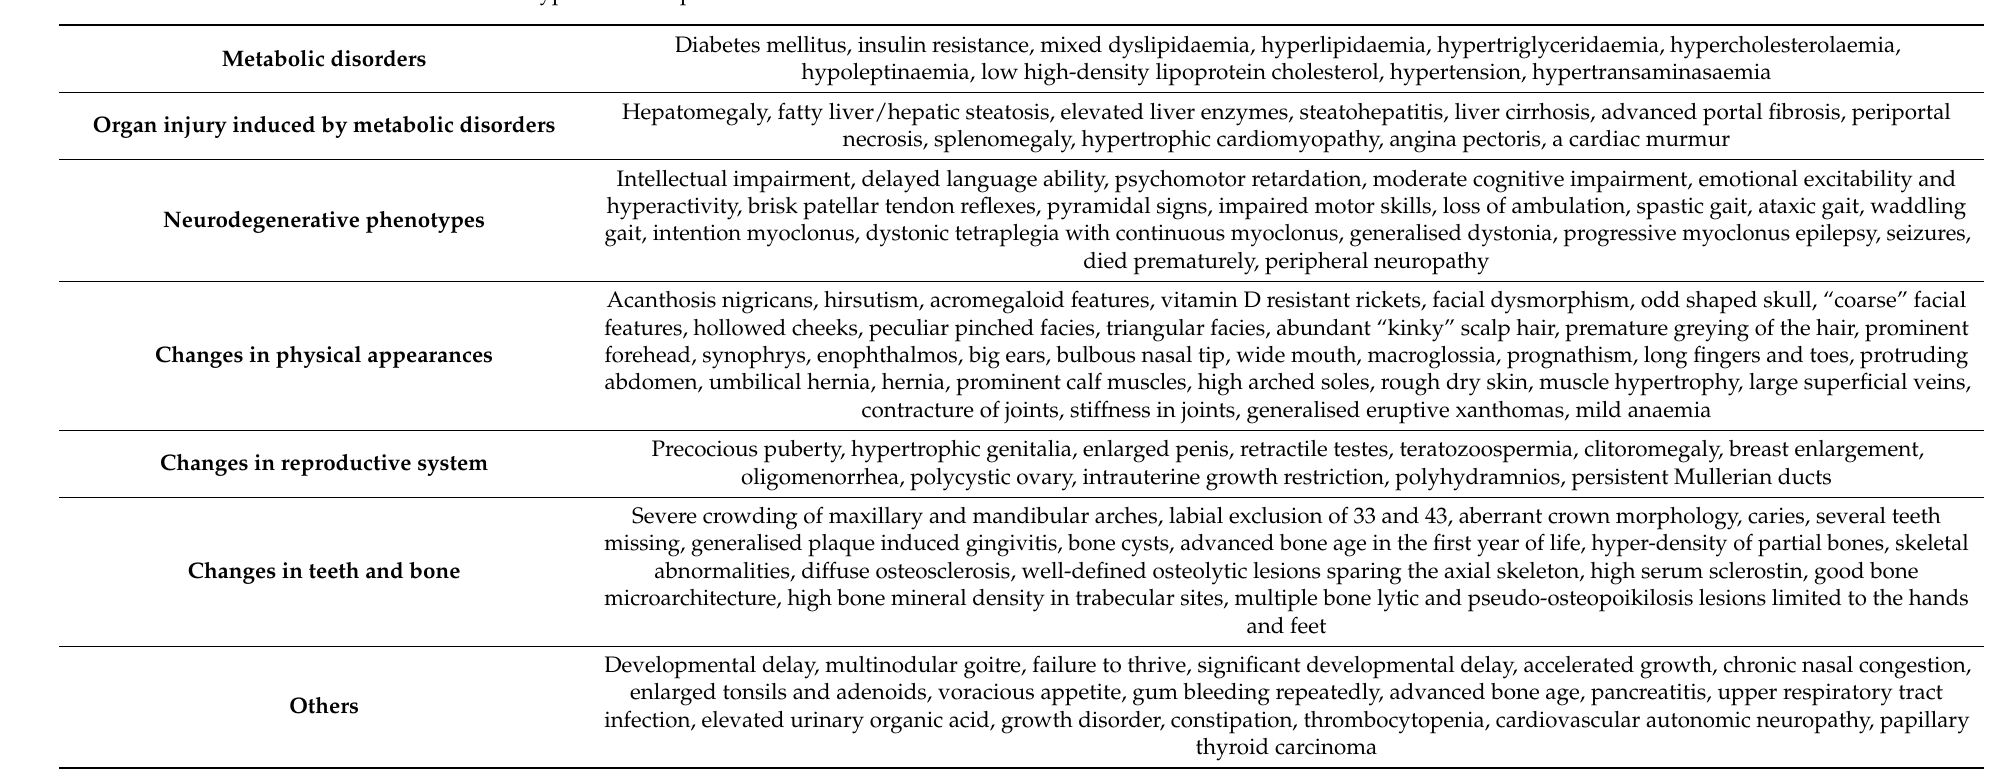
Table 2. Phenotypes of CGL2